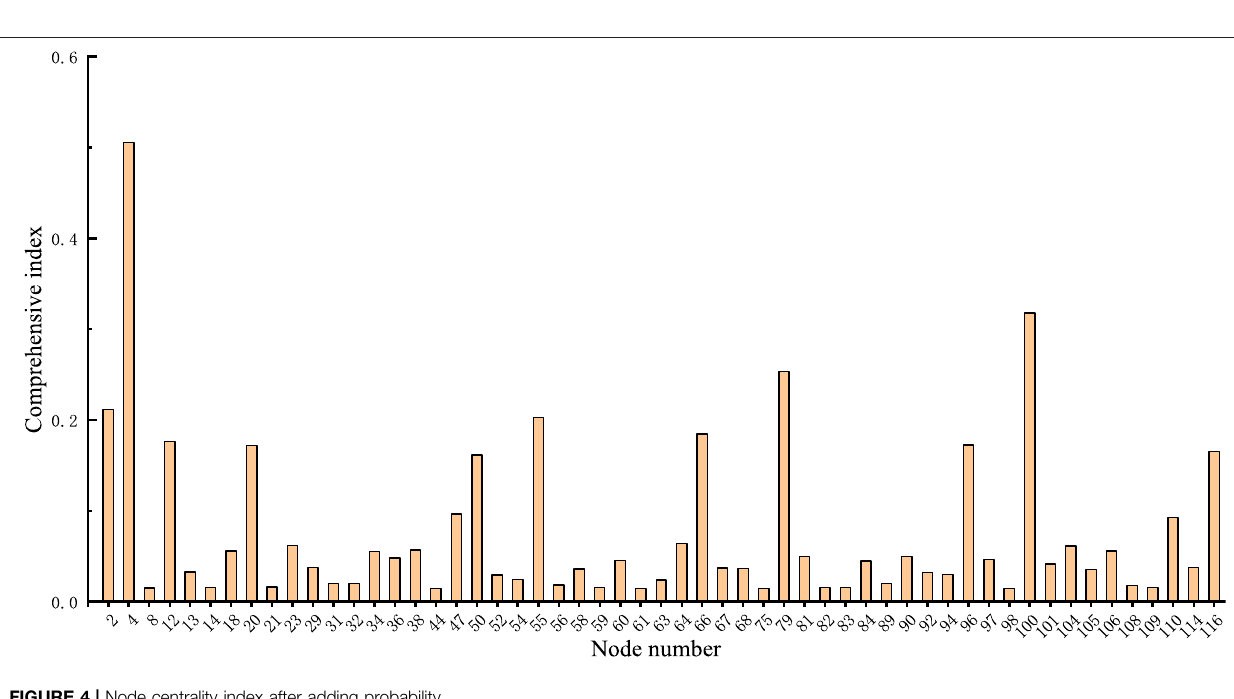
FIGURE 4 | Node centrality index after adding probability.